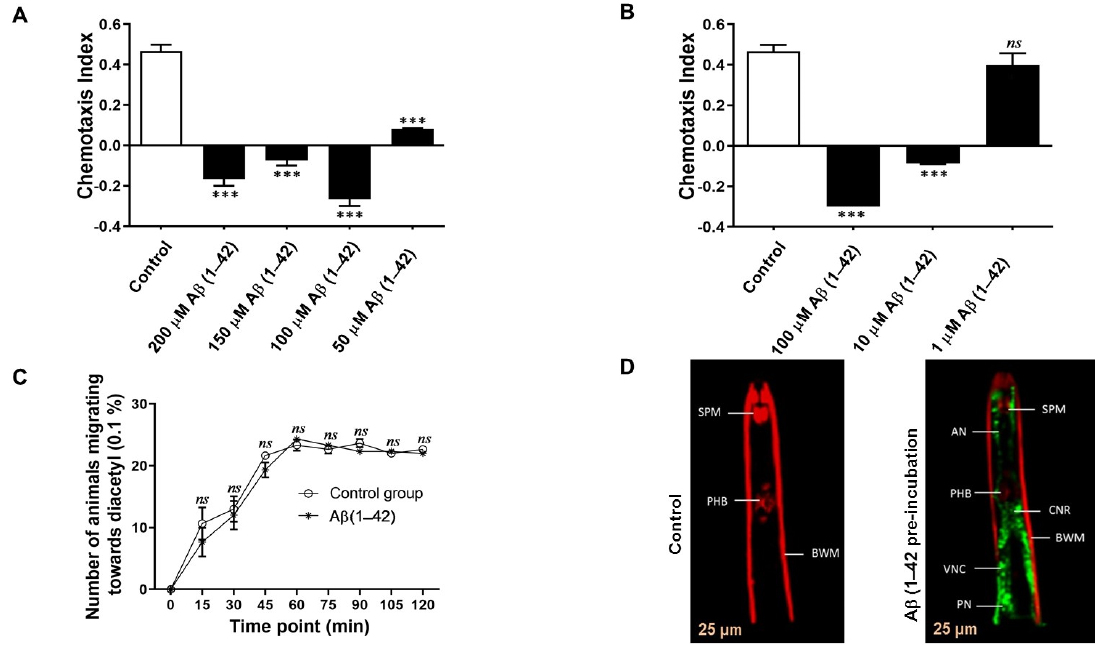
Figure 2. 24 h exposure to amyloid- β (A β ) (1–42) affects G. pallida chemosensing in a concentration-dependent manner, but the chemosensing of C. elegans is not affected. ( A ) Compared with the vehicle control (1% DMSO in ddH 2 O), A β (1–42) concentrations between 50 and 200 µM affected the chemotaxis Index (CI) of G. pallida to mannitol; ( B ) It is demonstrated that CI was affected at A β (1–42) concentrations as low as 10 µM (but not 1 µM). Approximately 100 G. pallida organisms were used per observation ( A , B ). ( C ) Groups of C. elegans were pre-incubated in the vehicle control or with A β (1–42) at concentration of 100 µM, and their migration response to chemoattractant (0.1% diacetyl dissolved in 0.99% ethanol) was measured. C. elegans was unaffected. Approximately 30 nematodes (wild-type N2—synchronised young adult age) per observation. Data demonstrated that A β (1–42) had no effect on the chemotaxis response of C. elegans towards the attractant compared with the vehicle control; ( D ) Confocal microscopy of amyloid- β (A β ) (1–42)-treated G. pallida . G. pallida pre-incubated for 24 h with A β (1–42) showed A β -specific fluorescence staining (green) which was not co-localised with muscle staining (red). In second-stage juveniles (J2s), A β (1–42) was in the ‘brain’, i.e., the circumpharyngeal nerve ring (CNR), posterior to the pharyngeal bulb (PHB), and in amphid neurons (AN) running anteriorly towards the stylet protractor muscles (SPM) and parallel to the body wall muscle (BWM). It is also shown in the ventral nerve cord (VNC) and in phasmid neurons (PN). Scale bars = 25 µm. The data are mean ± SEM ( n = 3). ns (not significant), and *** p < 0.001, compared with control.